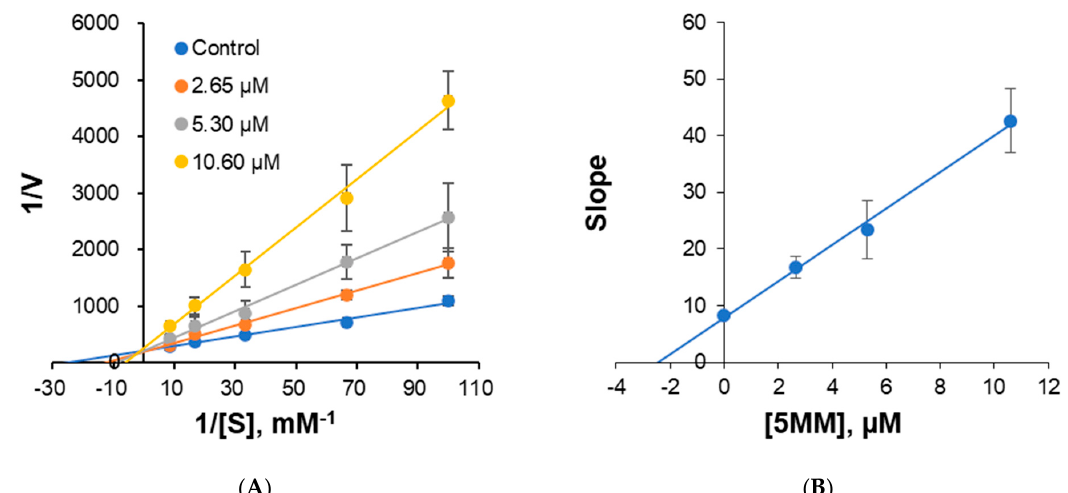
Figure 3. Lineweaver–Burk plots for hMAO-A inhibition by 5MM ( A ) and secondary plot with slopes vs. 5MM concentrations ( B ). Five substrate concentrations (0.01, 0.015, 0.03, 0.06, and 0.12 µM) were used, and three inhibitor concentrations were used (~1/2 × IC 50 , ~IC 50 , and ~2 × IC 50 ). Error bars are the results of duplicate experiments.